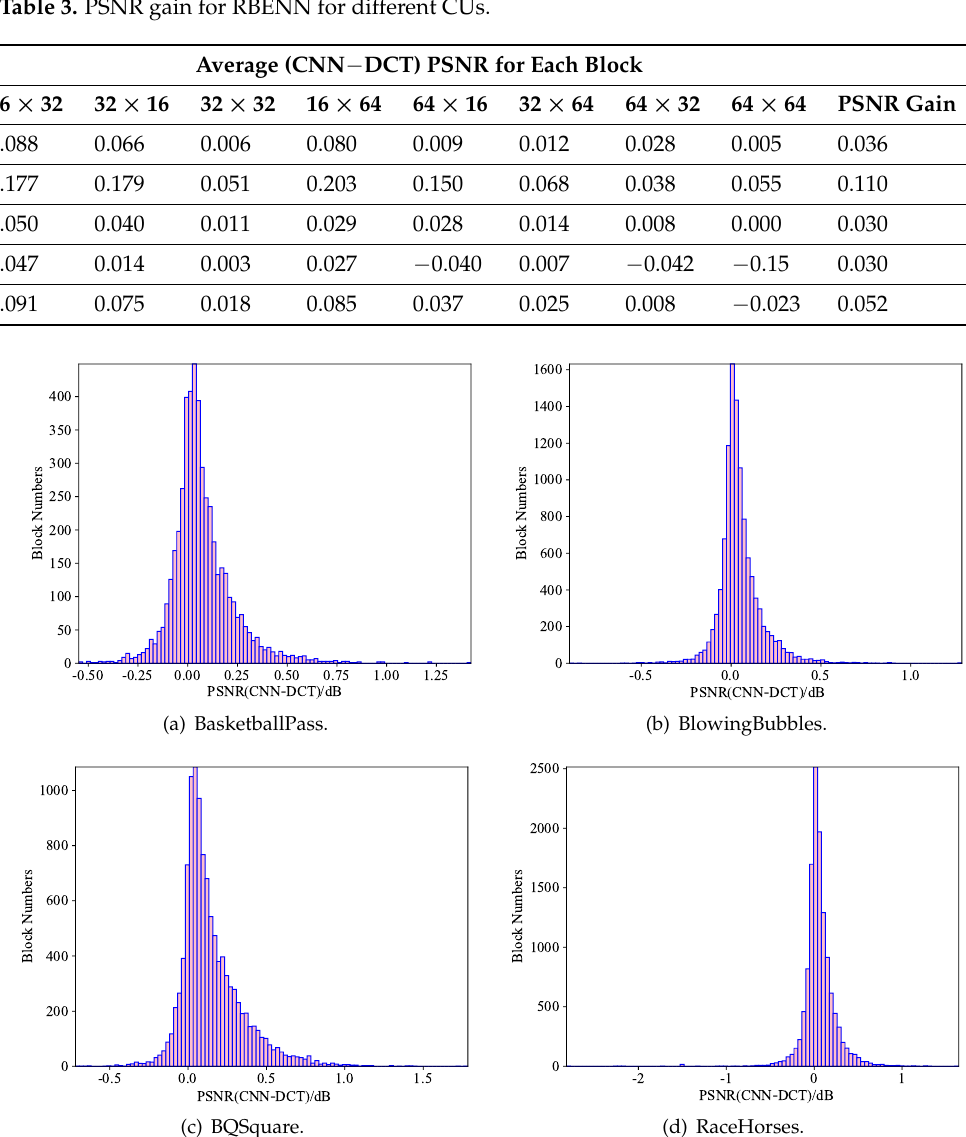
Table 3. PSNR gain for RBENN for different CUs.